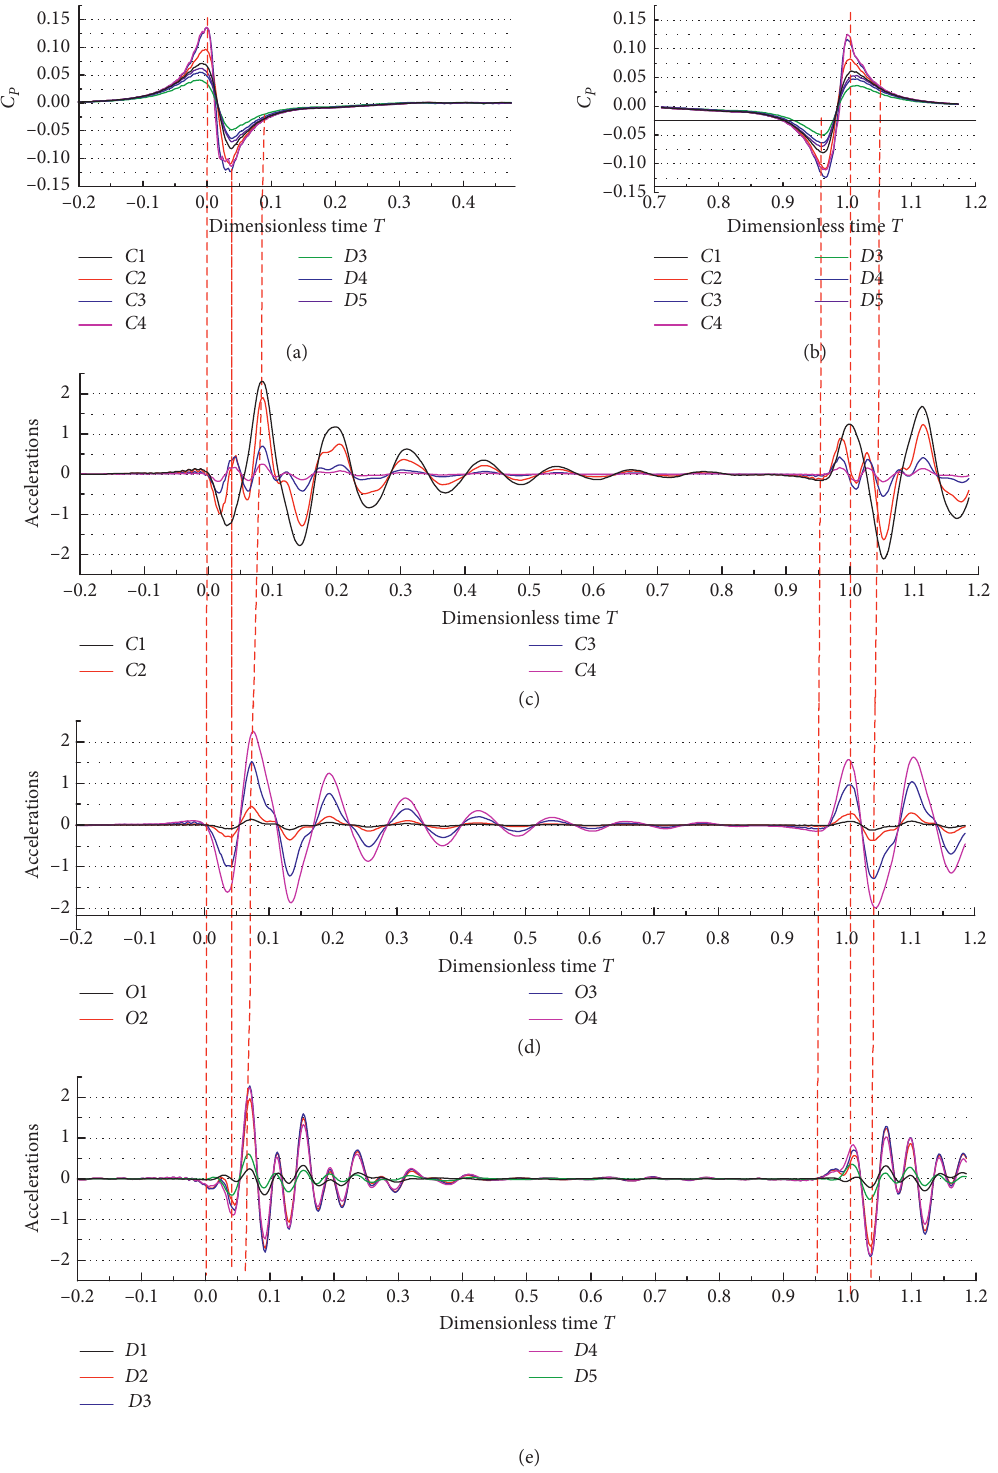
Figure 16: Time histories of the pressure coefficients and peak acceleration under dimensionless time when train on the near-line: (a) head pulse, (b) tail pulse, (c) peak acceleration on the closed side, (d) peak acceleration on the open side, and (e) peak acceleration on the top